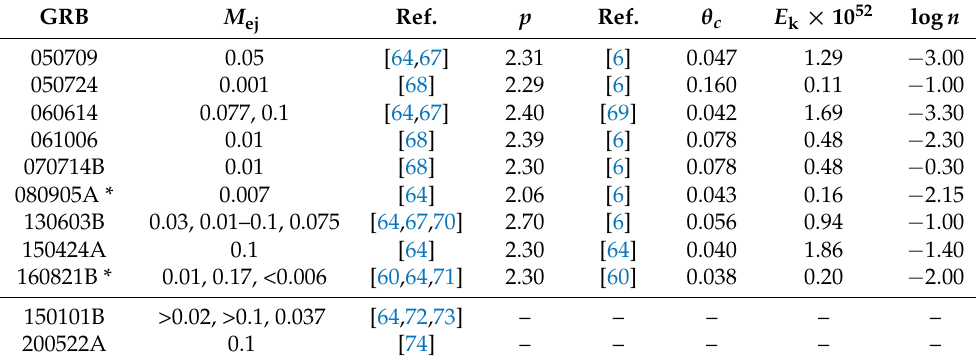
Table 2. Short GRBs with kilonova candidates. Estimated ejecta masses are from the respective reference column—where more than one mass is listed, the values are in the reference order; the bold value is that used to determine the jet collimation for the models shown in Figure 8. GRBs 150101B and 200522A, below the line, are not included in our optical lightcurve sample. The 4th and 5th columns show the value of index p used for the model afterglow lightcurves, and the relevant reference. The last three columns show the opening angle, the isotropic equivalent kinetic energy, inferred from the jet structure in each case, and the ambient particle density used for the lightcurves in Figure 8. The ejecta mass ( M ej ) is in units M (cid:12) , core angle ( θ c ) is in radians, kinetic energy ( E k ) is in erg, and the ambient density ( n ) in cm − 3